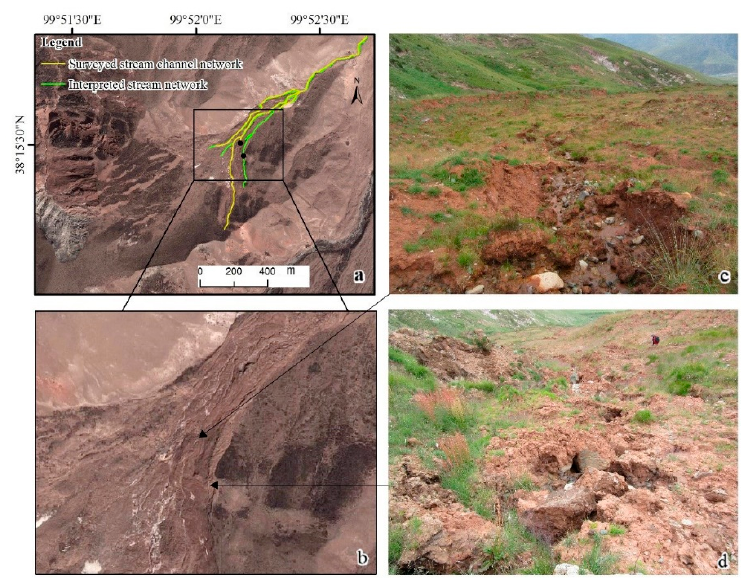
Figure 3. The surveyed stream channel network in field work and interpreted channel stream by using the high-resolution image. ( a ) shows the field-mapped stream networks with the aids of GPS and high-resolution image. ( b ) reflects the location of photos c and d. ( c ) is a photo of stream during tracking along the stream, and ( d ) is a photograph captured for the dried ditch.